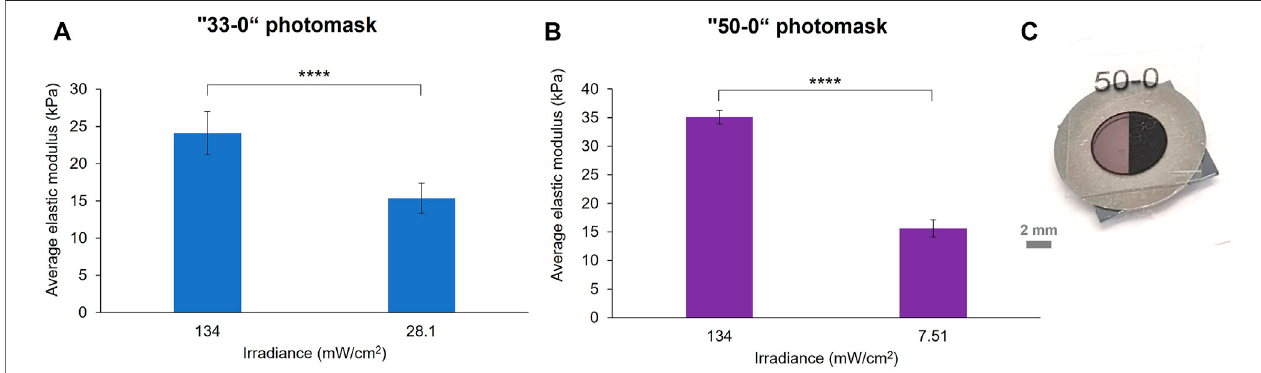
FIGURE 3 | Stiffness patterning of 10 wt% GelMA hydrogels crosslinked for 4 min under the green LED with two binary photomasks: “ 33 – 0 ” (A) and “ 50 – 0 ” (B) masks. The elastic modulus of the hydrogels was signi fi cantly reduced by the opaque area of the photomask, which modulated the green LED irradiance (error bars are thestandarderroroveratleastsixforcemapsontwosamplesperphotomask, p < 0.0005).Photographofa “ 50 – 0 ” binaryphotomaskplacedontopofapre-gelsolution into a mould (C)